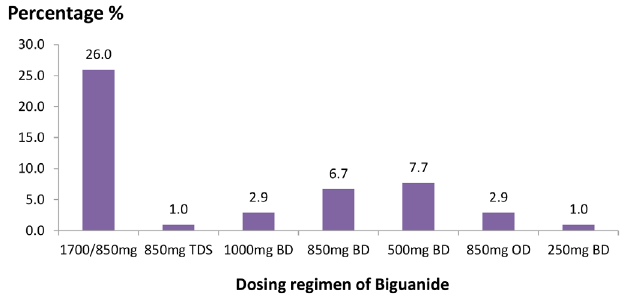
FIGURE 4 - Biguanide dosing agents for T2DM patient with DR (N=104); BD, twice daily; OD, once daily; TDS, three times daily.